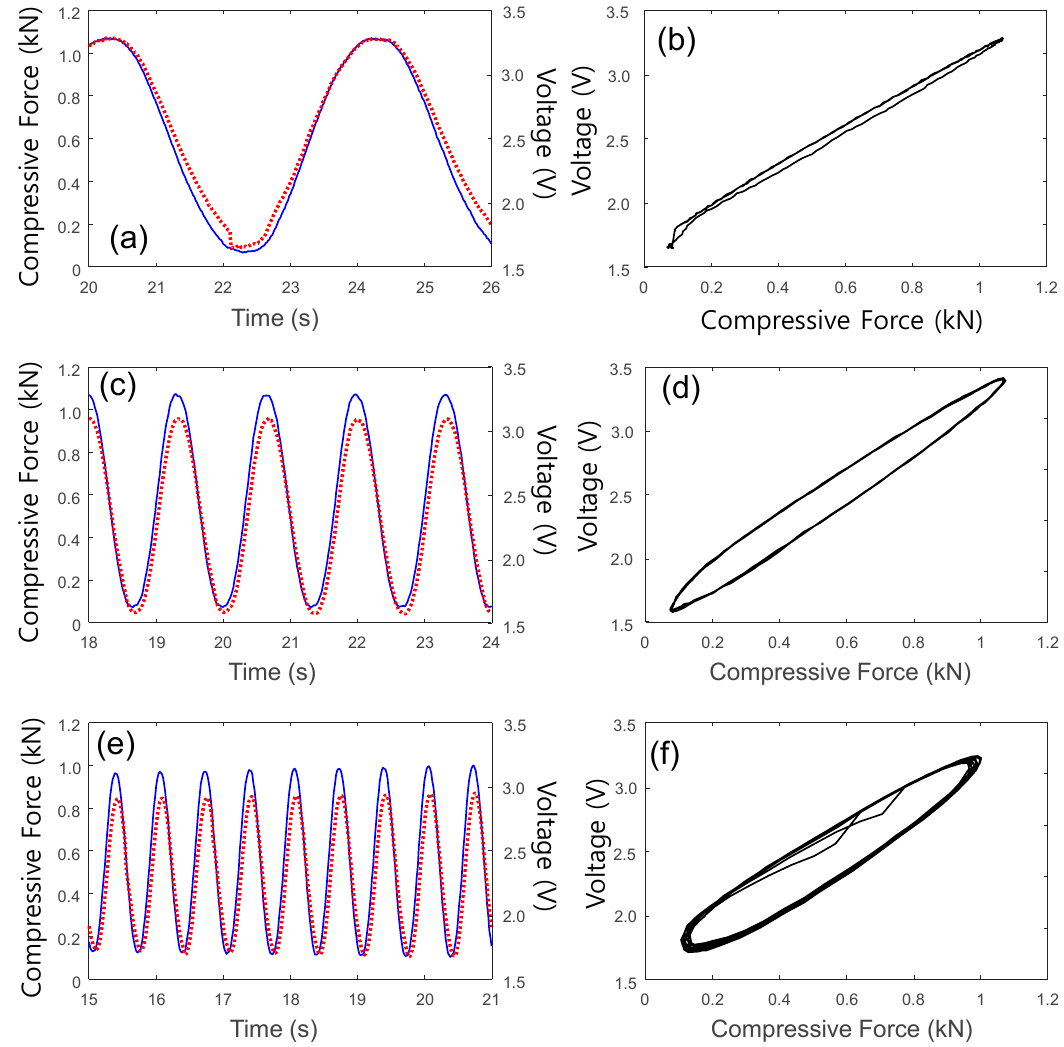
Figure 8. Frequency-dependent dynamic piezoresistive responses to a sinusoidal input and their corresponding hysteresis curves. ( a , b ): 0.25 Hz; ( c , d ): 0.75 Hz; ( e , f ): 1.5 Hz.